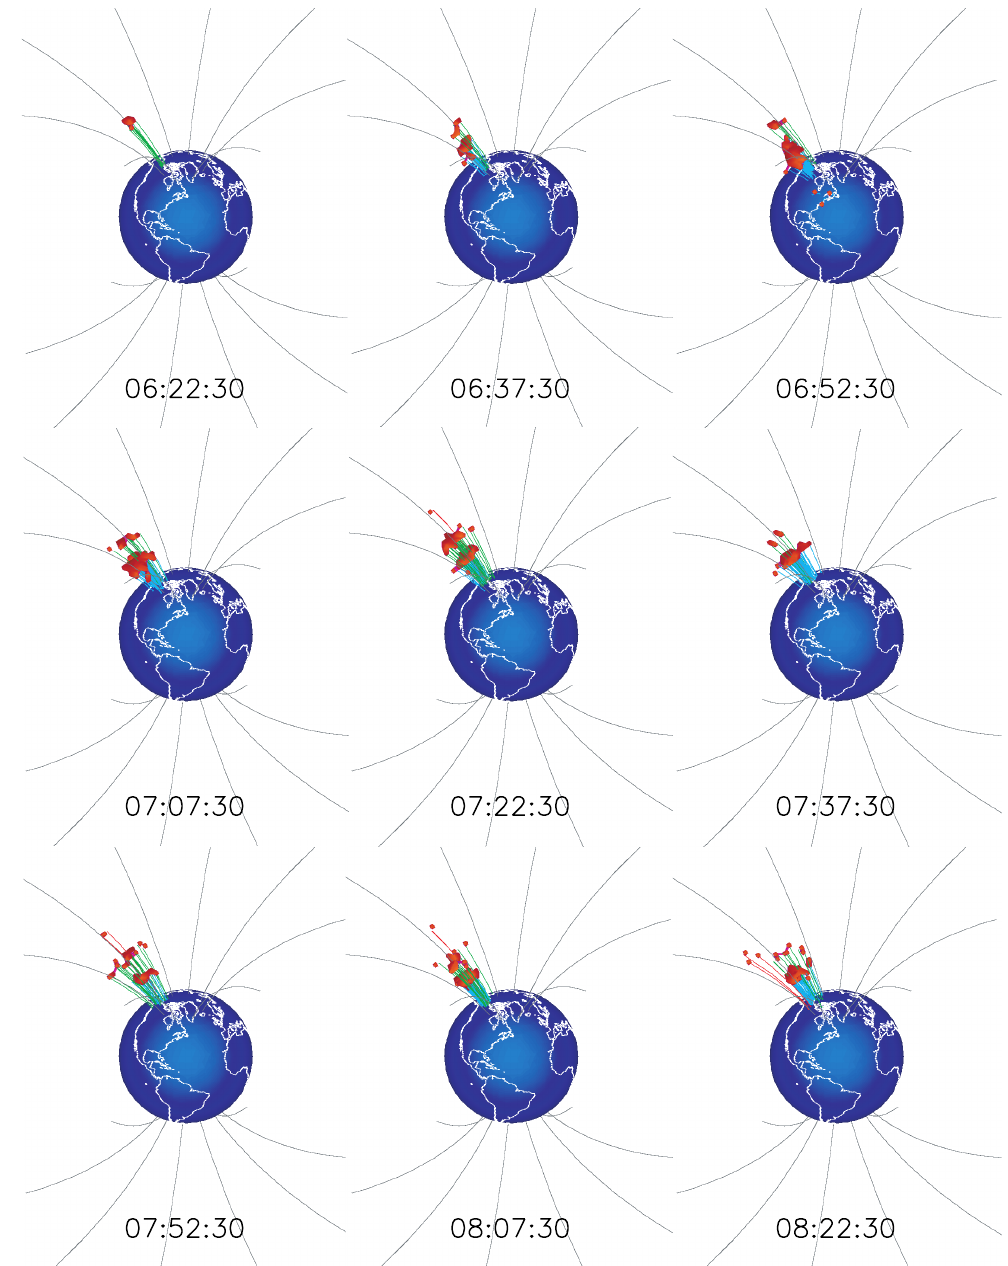
Fig. 6. Montage of AKR burst locations on 9 November 2002 between 06:22:30 and 08:22:30 UT. Subplots show individual AKR burst locations (0.3s × 1kHz data windows) in consecutive 15-min time intervals. Magnetic field lines connecting burst locations to the Earth’s surface are shown as lines coded by AKR burst frequency (125kHz red, 250kHz green, 500kHz